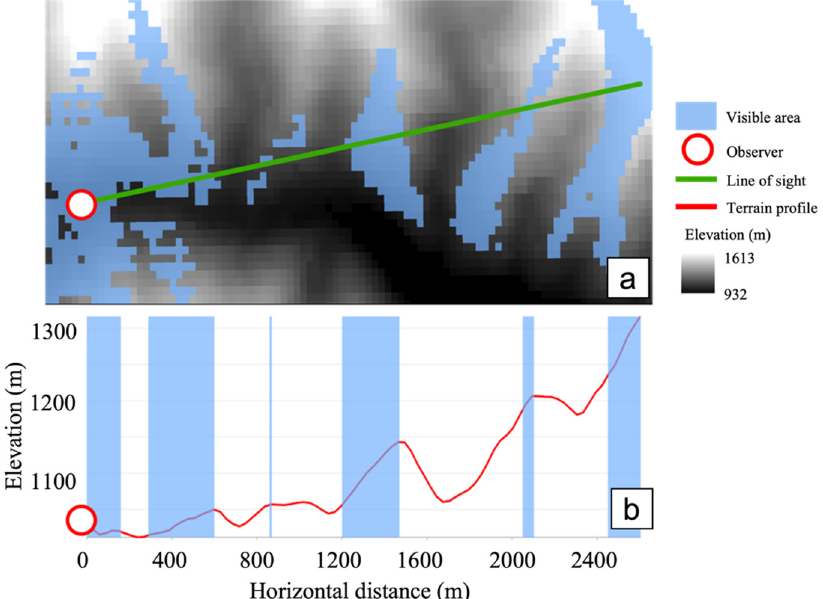
Figure 2. Viewshed schematic. ( a ) Map of elevation overlaid with viewshed results indicating visible pixels (blue) calculated from the observer. Green line indicates a single line of sight. ( b ) Aligned terrain profile of line of sight (red line) with blue shading indicating visible features.